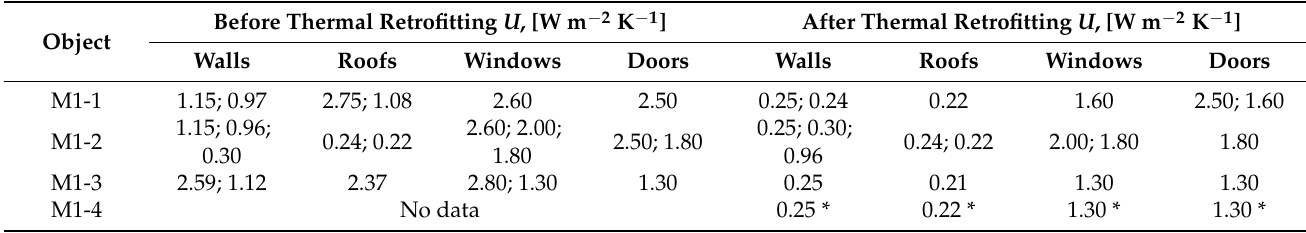
Table 2. Heat transfer coefficients U for external partitions in buildings from group